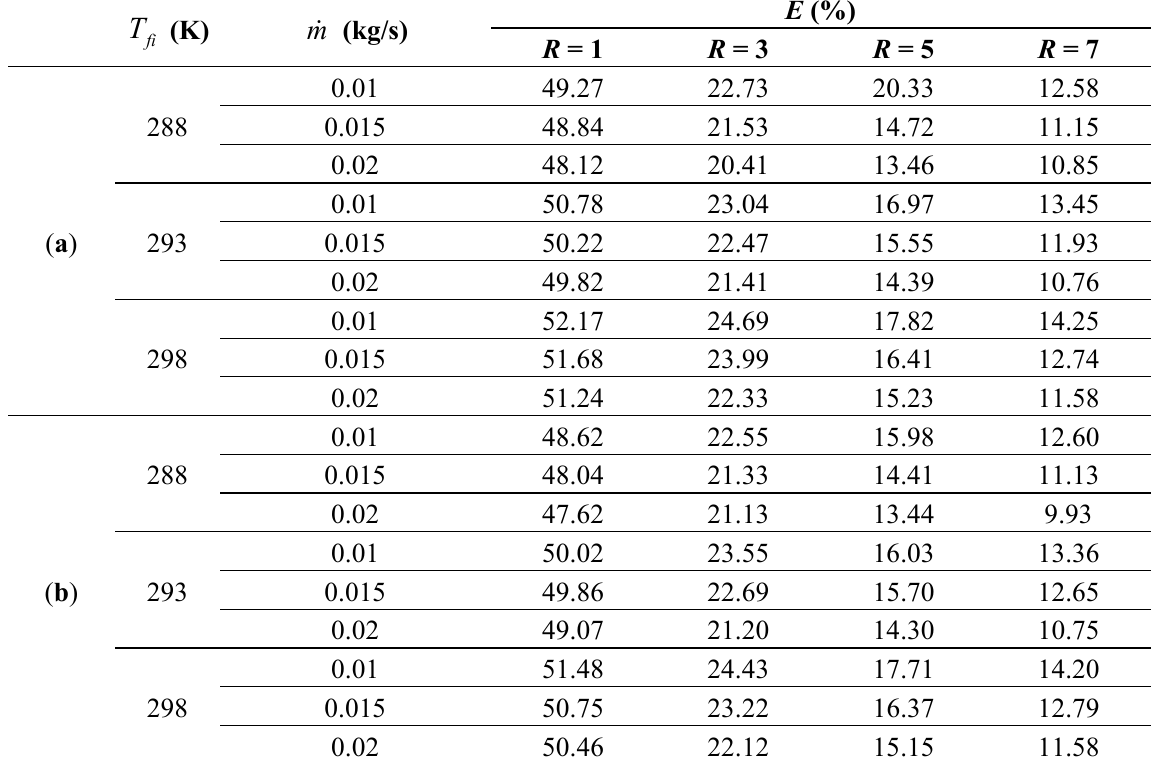
Table 3. Further enhancement of performance for: ( a